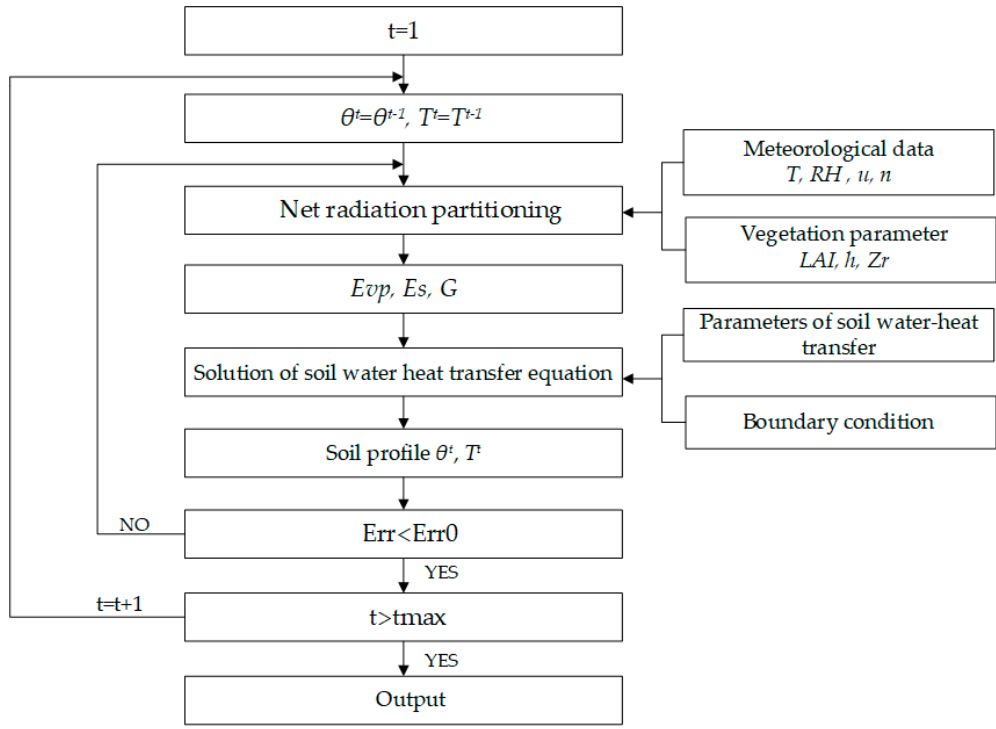
Figure 4. The calculation flowchart of the SPAC module.